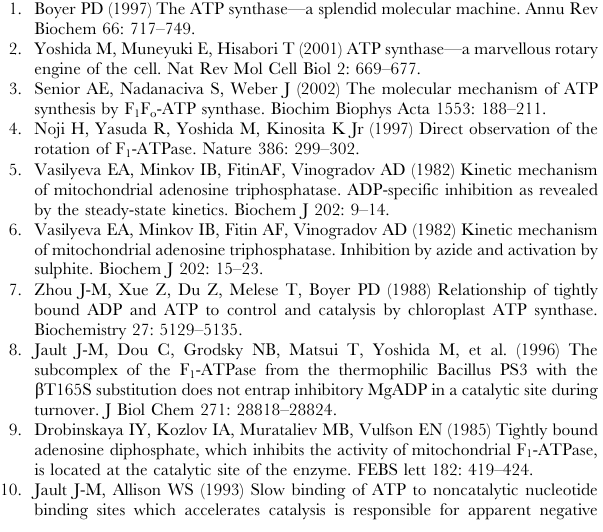
Figure S1 Emission spectra of a 3 b 3 c D NC of BF 1 . Fluores- cence emission spectra of a 3 b 3 c D NC in the absence and presence of 1 mM ATP were measured as Fig. 1. Solid line and dotted line represent in the absence and presence of ATP, respectively. The fluorescence values are normalized to peak in the absence of ATP as 100%.